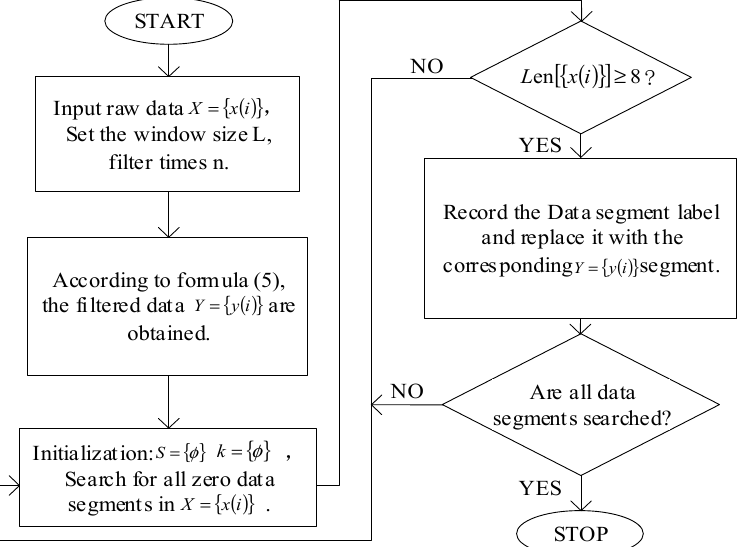
Figure 6. Improved Moving Average Filtering Algorithm flow chart. Algorithm 1 An Improved Moving Average Filtering Algorithm